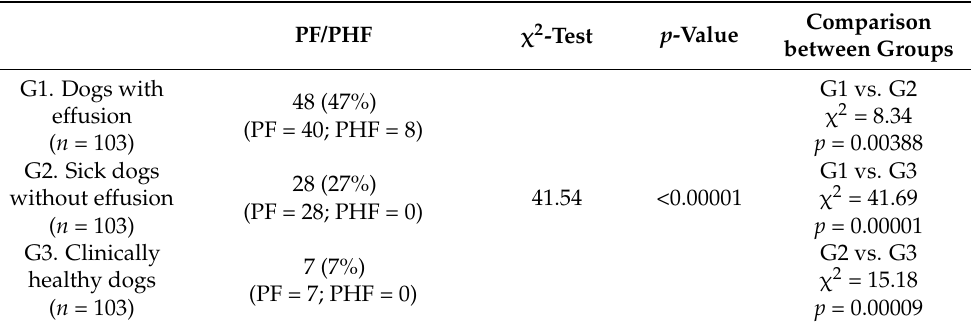
Table 2. Differences in the frequency of PF/PHF in dogs with intracavitary effusion as compared with sick dogs without effusion and clinically healthy control dogs (combined data from studies [41,42]). The sick dogs without effusion and clinically healthy dogs were individually matched for age, sex, and breed to the dogs with intracavitary